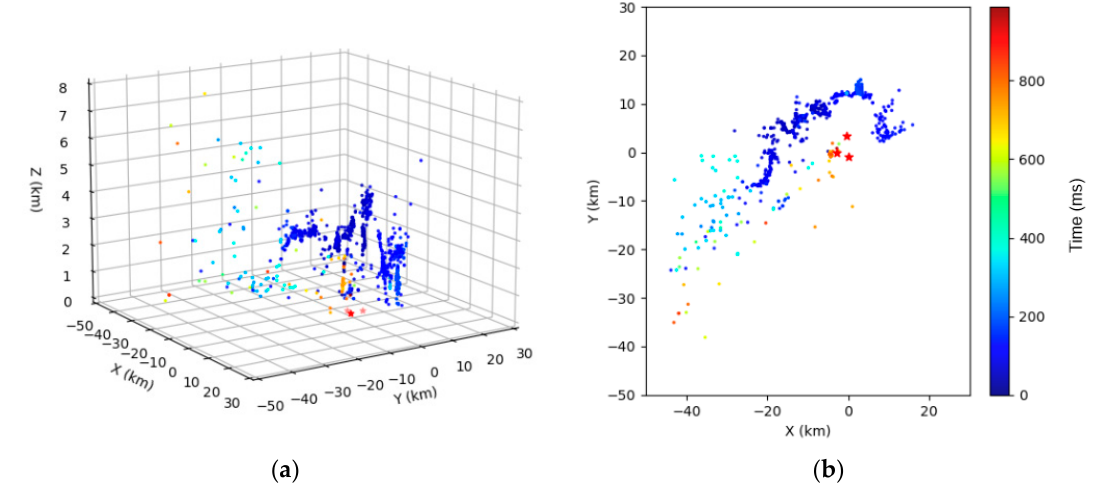
Figure 6. 3D mapping result of the lightning flash by DALMA color-coded in time. Three pentagrams represent stations of InLMA. ( a ) 3D mapping; ( b ) Top view.